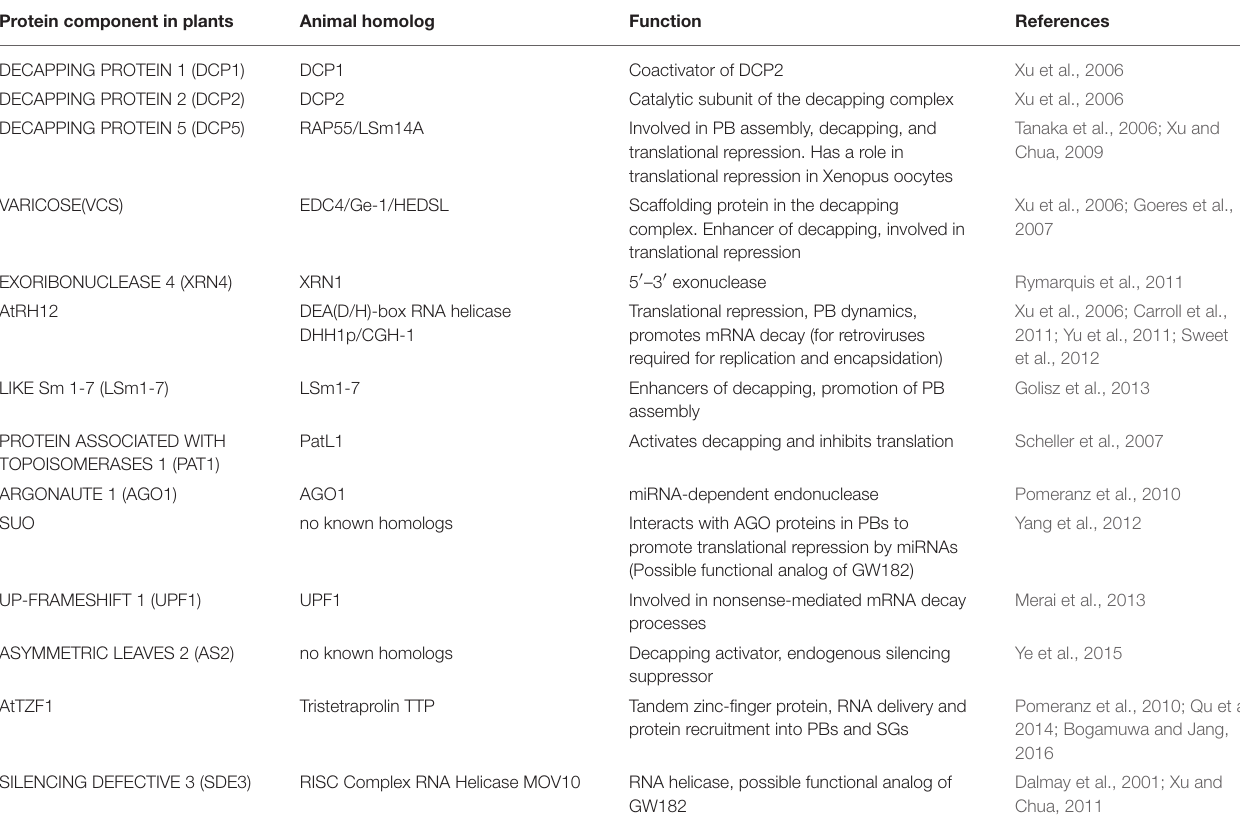
TABLE 2 | Plant processing body proteins and their animal